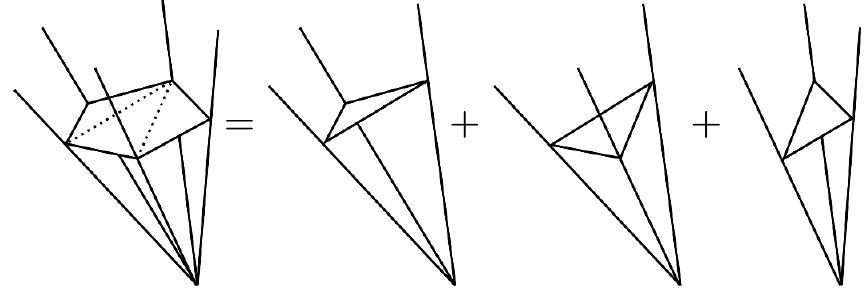
Figure 15 . Decomposing a polyhedral cone using a